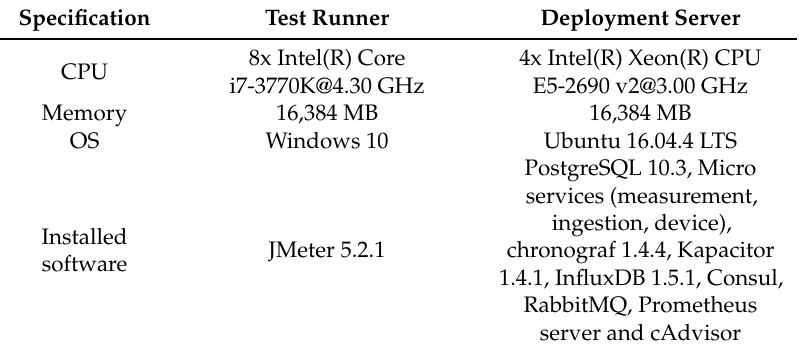
Table 2. Specifications of two environments used in this performance